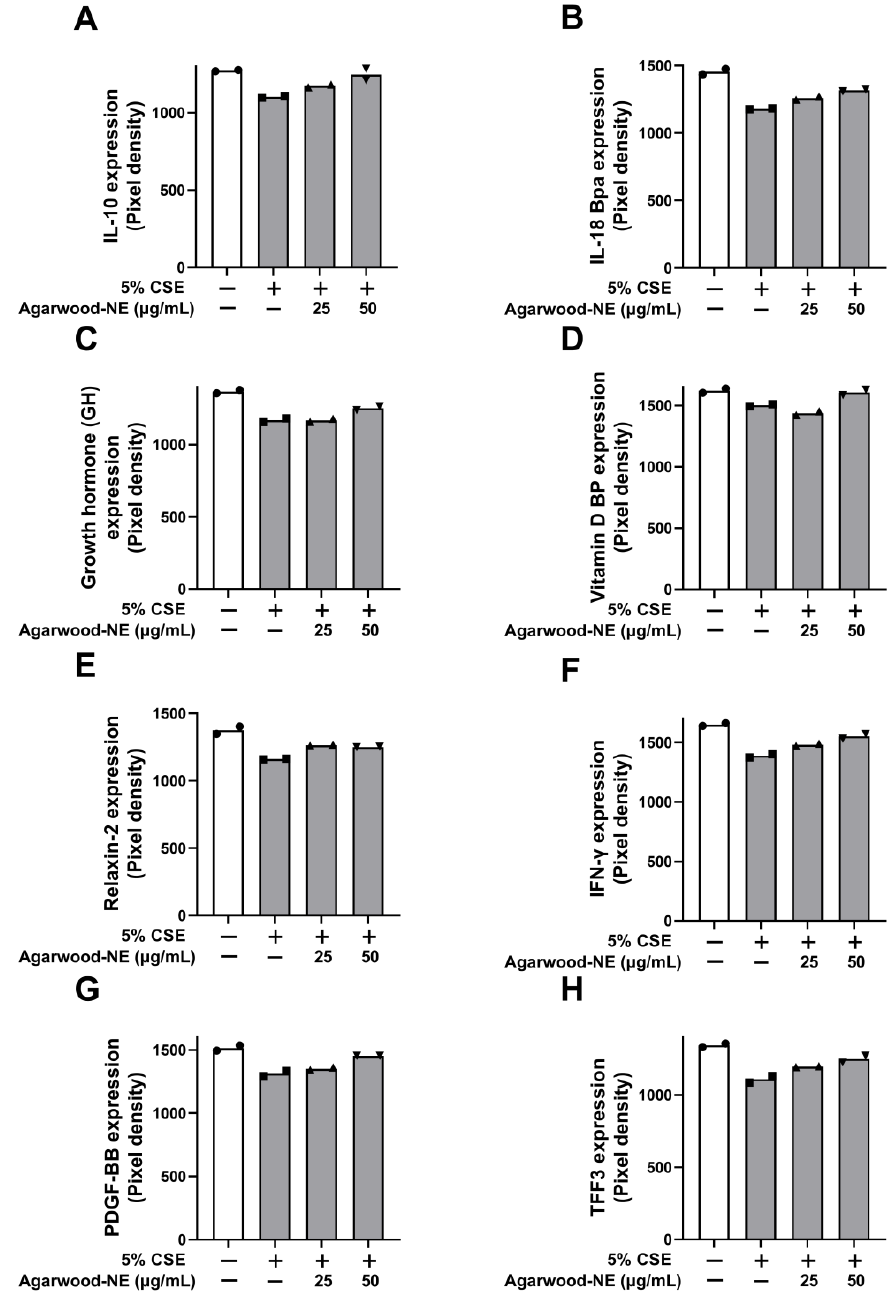
Figure 4. Effect of agarwood-NE on the CSE-inhibited production of anti-inflammatory mediators in human cytokine protein array. BCi-NS1.1 cells were pre-incubated for 1 h in the presence of 25 and 50 µ g/mL agarwood-NE, followed by exposure to 5% CSE for 24 h. The protein levels of IL-10 ( A ), IL-18Bpa ( B ), GH ( C ), VDBP ( D ), relaxin-2 ( E ), IFN- γ ( F ), PDGF-BB ( G ), and TFF3 ( H ) were determined via human cytokine protein array.